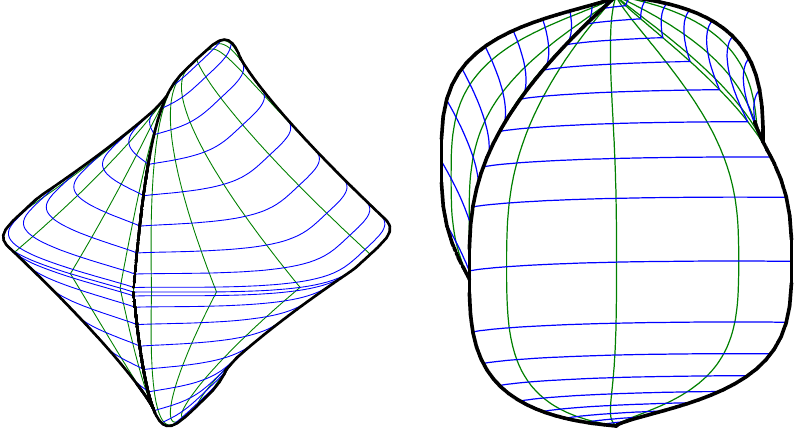
Figure 7. Different exponents: ( left ) p 1 = 4, p 2 = 0.8, p 3 = 1; ( right ) p 1 = 1, p 2 = 0.8, p 3 = 3.